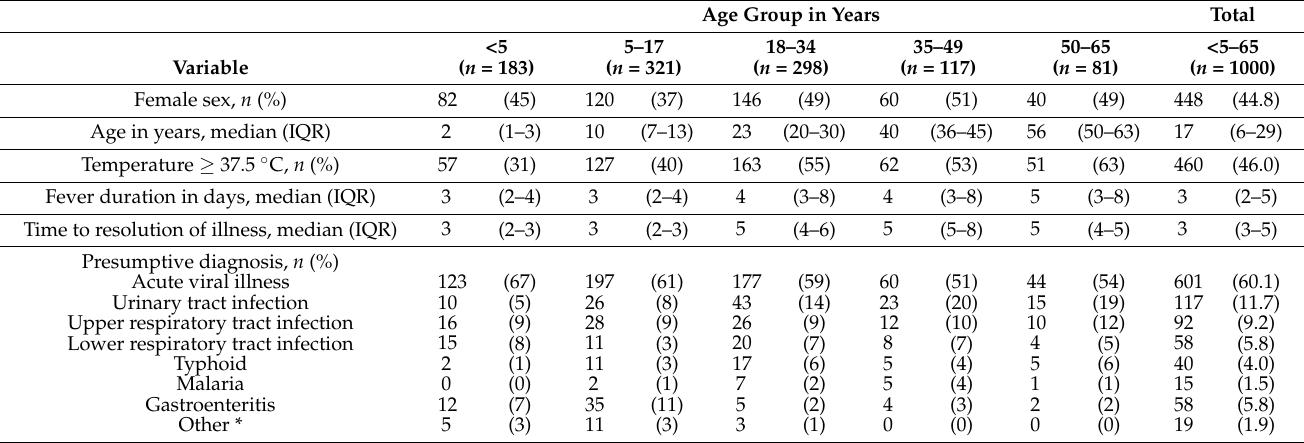
Table 1. Demographic and clinical characteristics of study participants by age